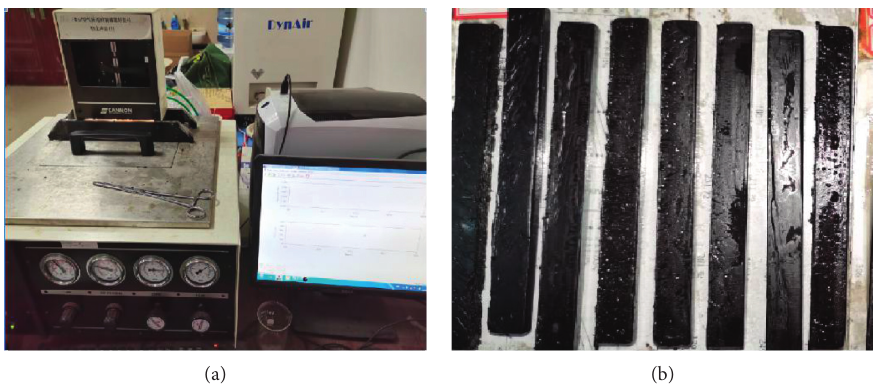
Figure 4: BBR test of high modulus asphalt: (a) BBR tester; (b) asphalt